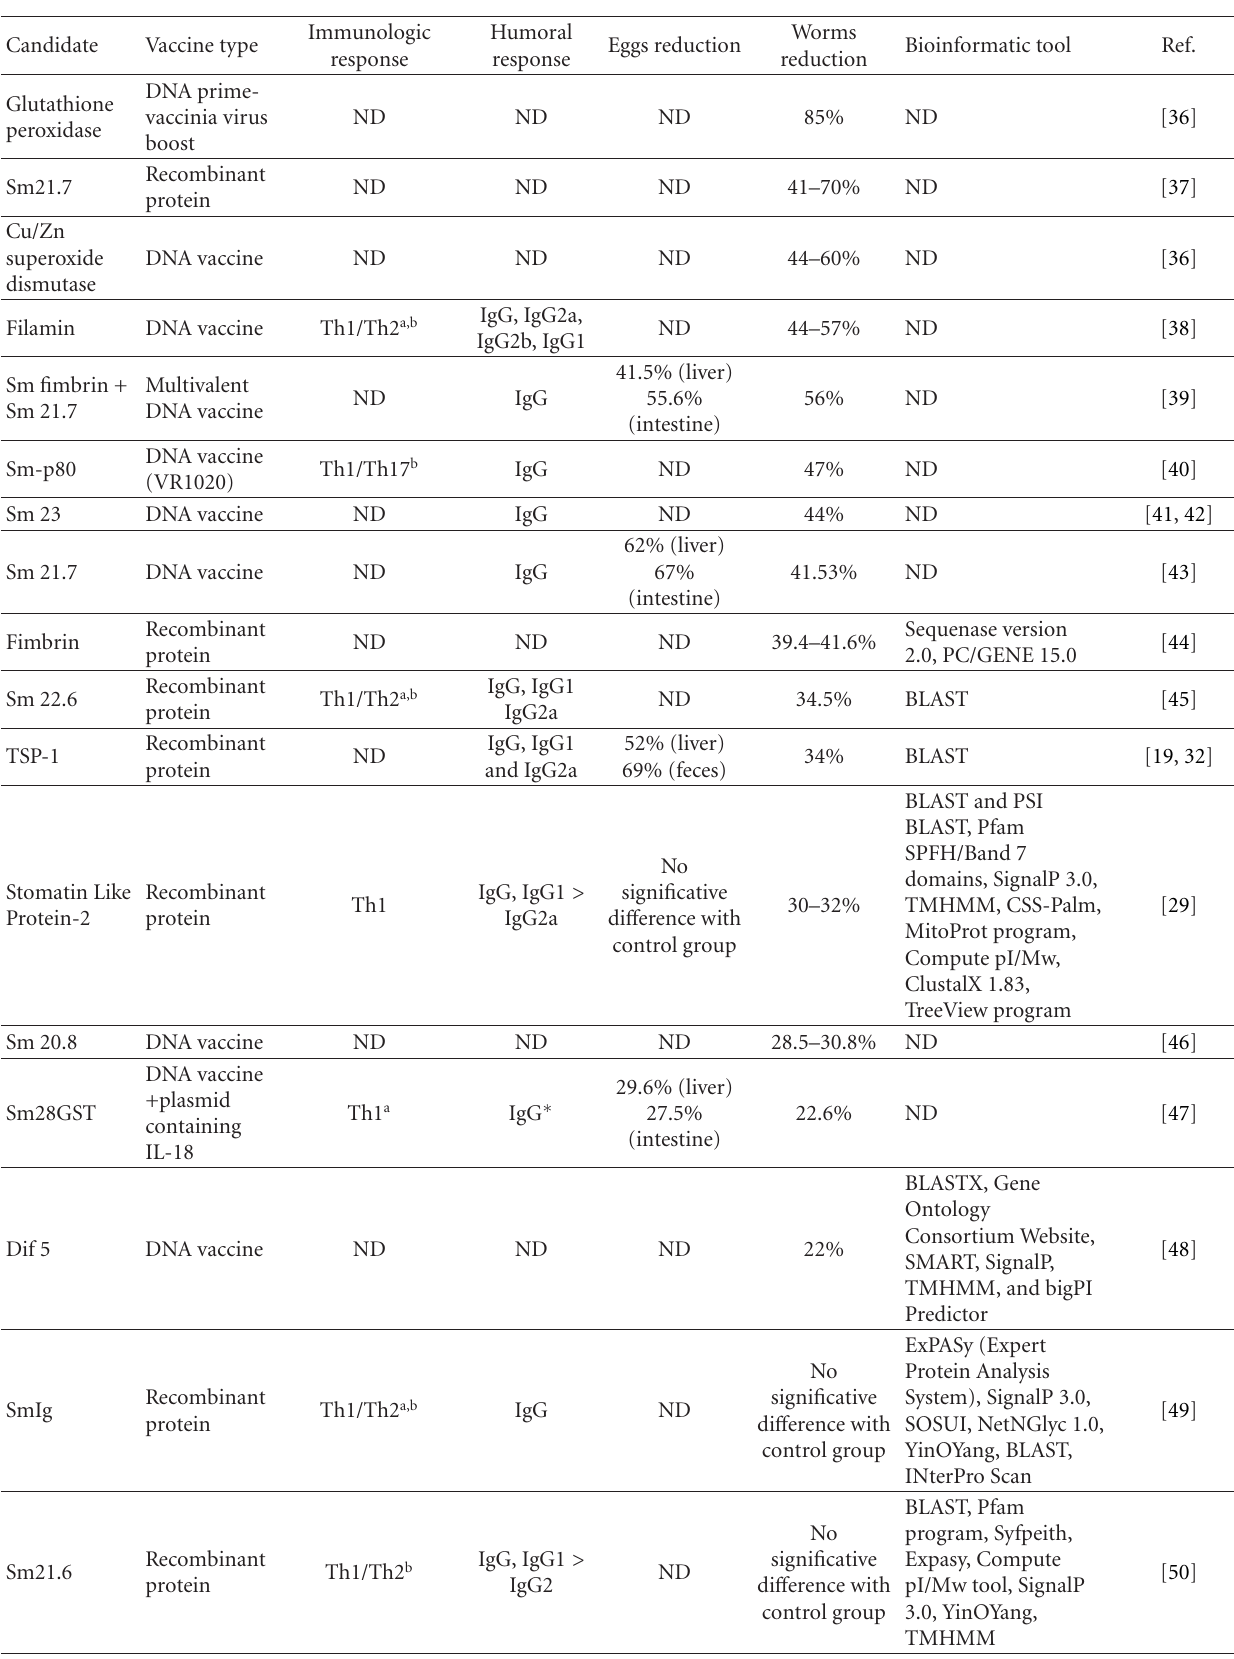
Table 2: Other S. mansoni tegument membrane proteins evaluated as vaccine